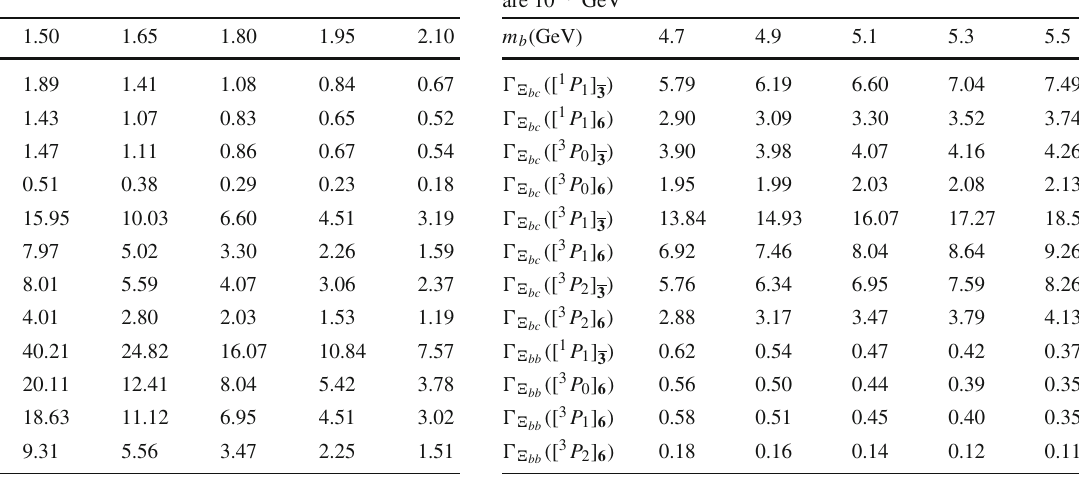
Table 5 Theoretical uncertainties for the production of P -wave (cid:2) bc and (cid:2)